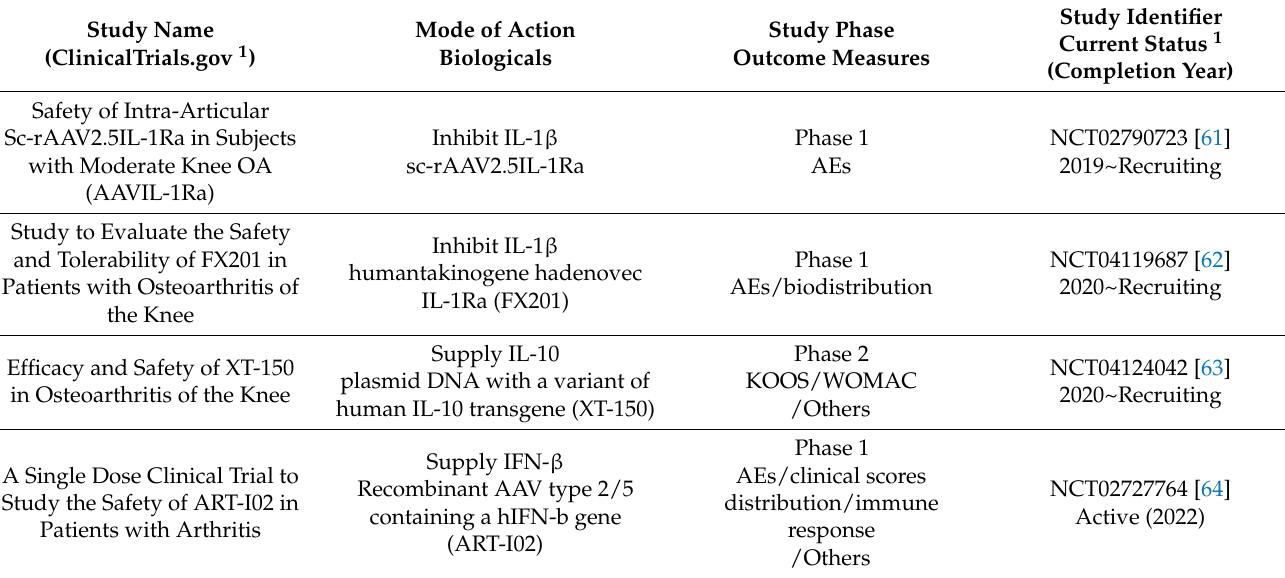
Table 3. Clinical trials of intra-articular delivery of gene therapy for OA